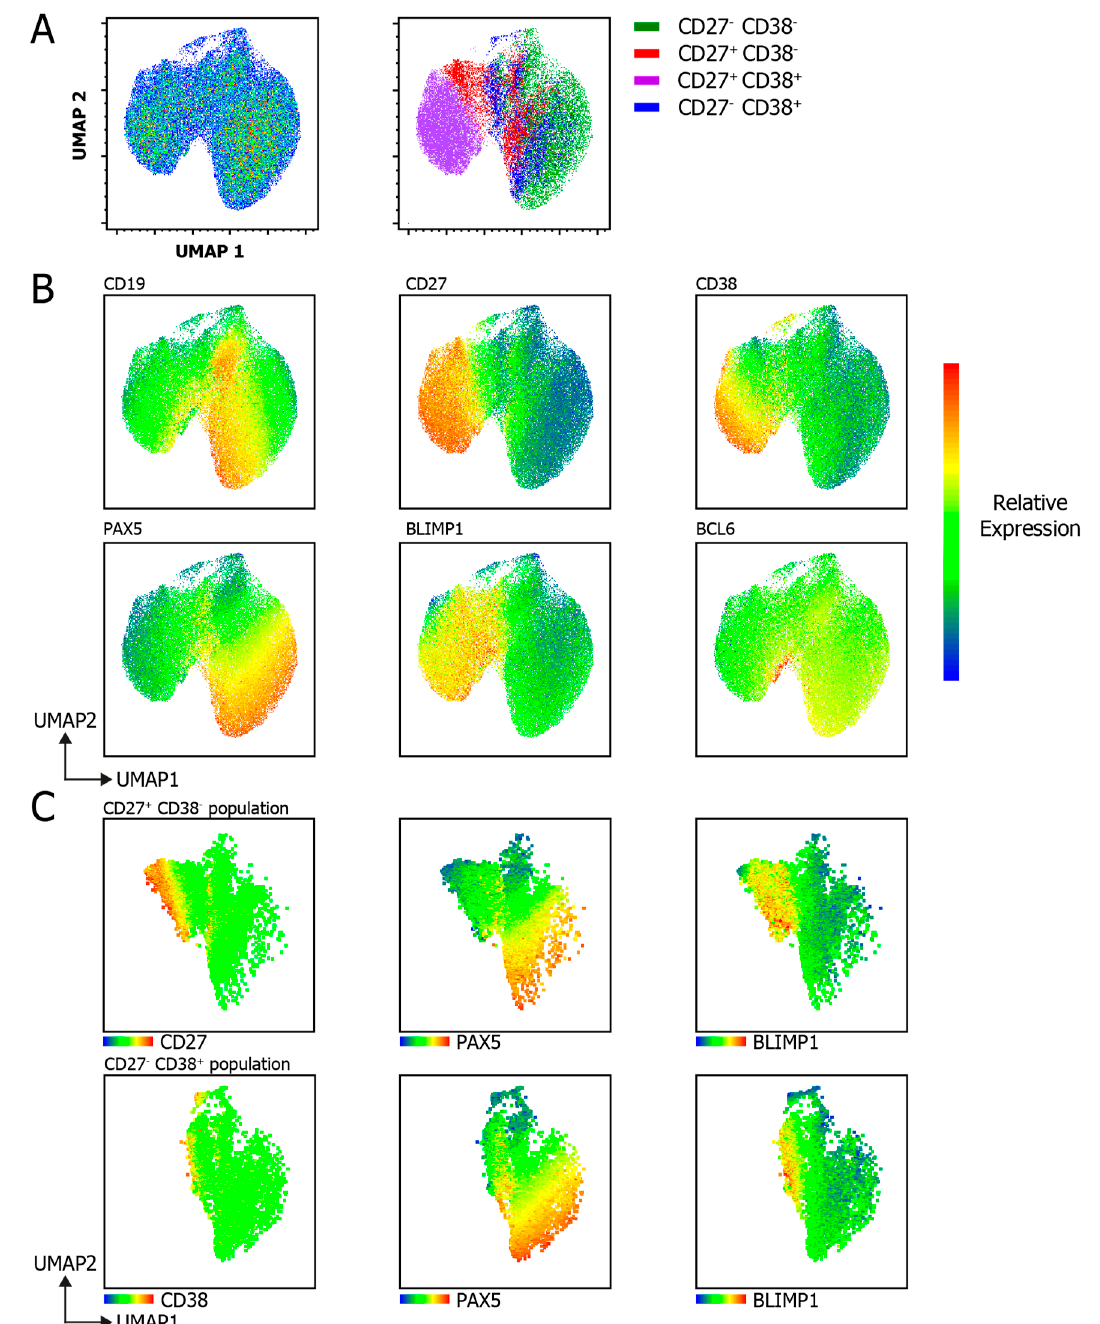
Figure 6. Uniform Manifold Approximation and Projection (UMAP) analysis of combined membrane marker and TF marker analyses upon B cell differentiation. UMAP clustering analysis on B cells stained for CD19, CD27, CD38, PAX5, BLIMP1 and BCL6 after 6-day culture with a human-CD40L-expressing 3T3 feeder layer, an anti-Ig F(ab) 2 mix (5 ug/mL) targeting IgM/IgG/IgA and recombinant IL-4 (25 ng/mL) and IL-21 (50 ng/mL) cytokines. ( A ) UMAP 2D scatter plot of 60,000 living, single CD19 + B cells from 3 donors (left), and the different CD27/CD38 subpopulations overlaid (right). UMAP settings were as follows: distance function, Euclidean; number of neighbors, 30; minimal distance, 0.5; and number of components, 2. ( B ) Heatmap of the relative protein expression of CD19, CD27, CD38, PAX5, BLIMP1 and BCL6 included in the UMAP analysis overlaid on the UMAP 2D scatter plot. ( C ) Heatmap of the relative protein expression of PAX5 and BLIMP1 within the isolated CD27 + CD38 − population (top) and CD27 − CD38 + population (bottom) overlaid on the UMAP 2D scatter plot.